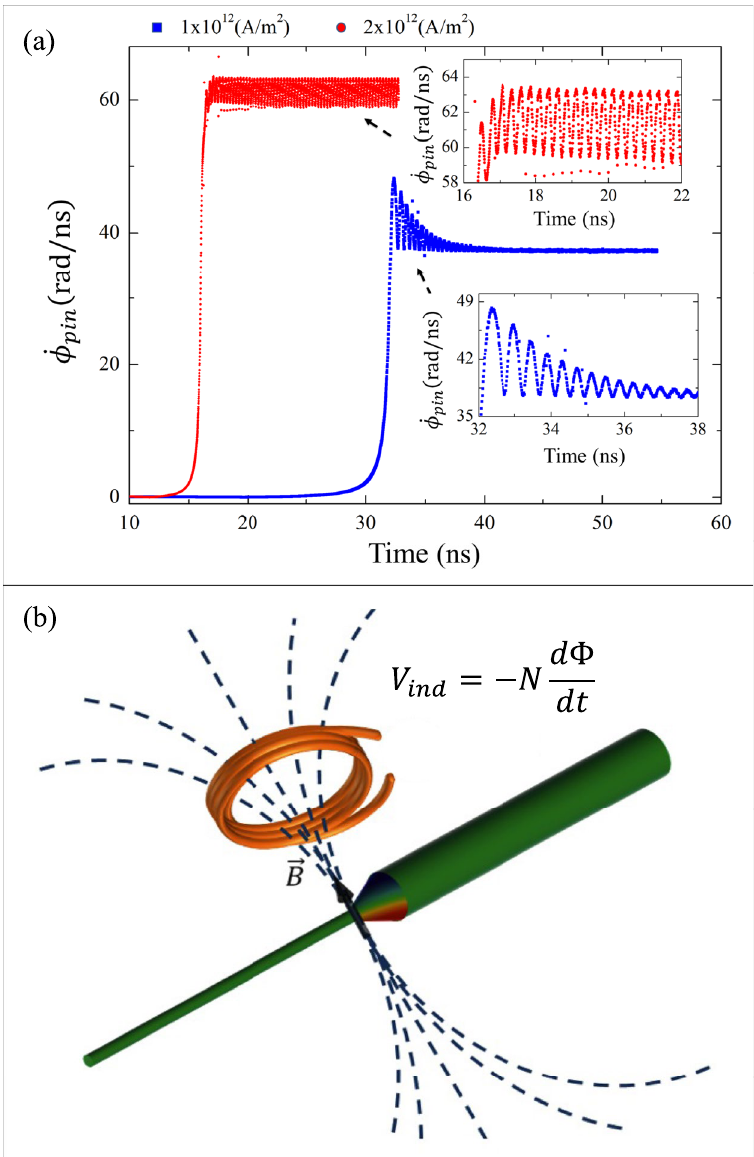
Figure 4. ( a ) Angular velocity for two current densities, where the TDW finds an equilibrium position due to competition between the electric current and the demagnetizing field. ( b ) Scheme of a nanogenerator where the generated alternating magnetic field induces an alternating voltage in a neighboring